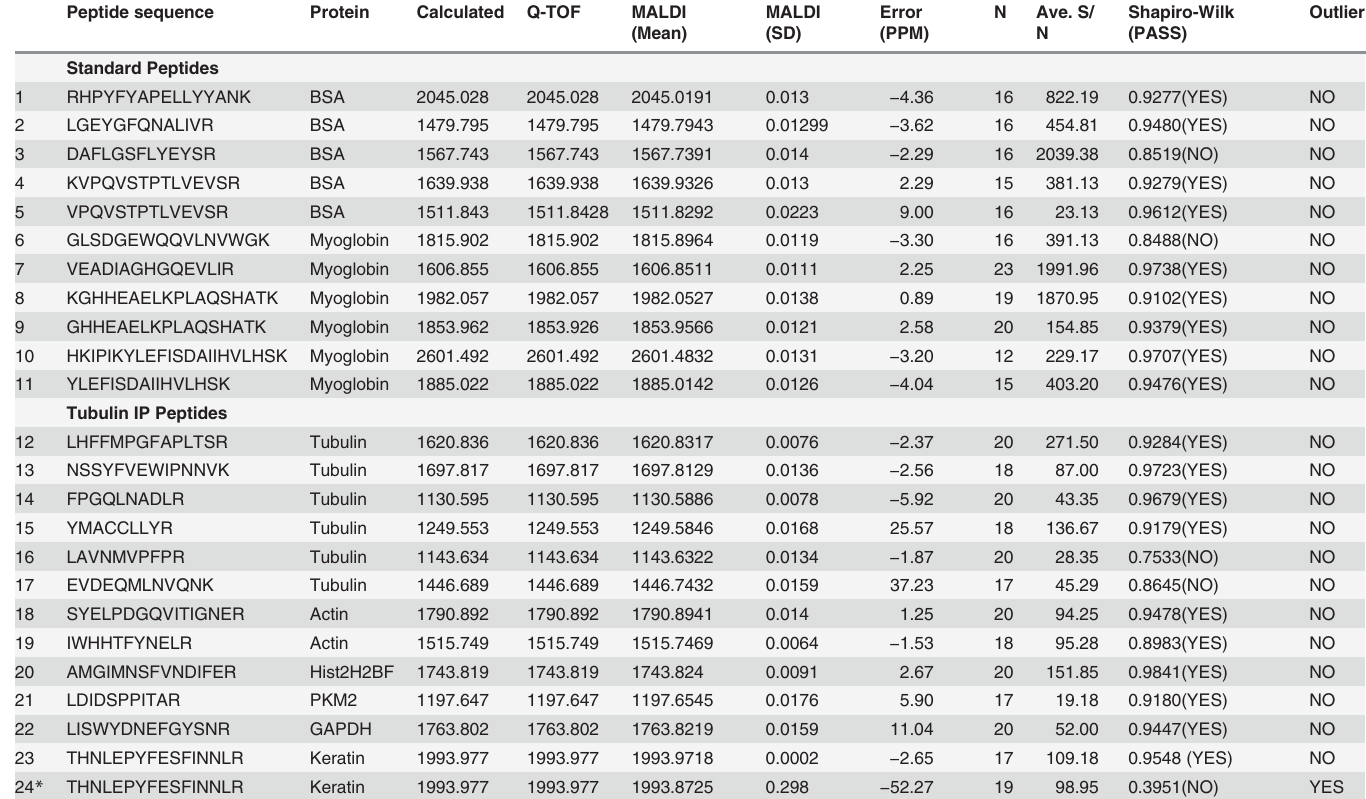
Table 1. Data and statistical calculations for protein standard and tubulin IP